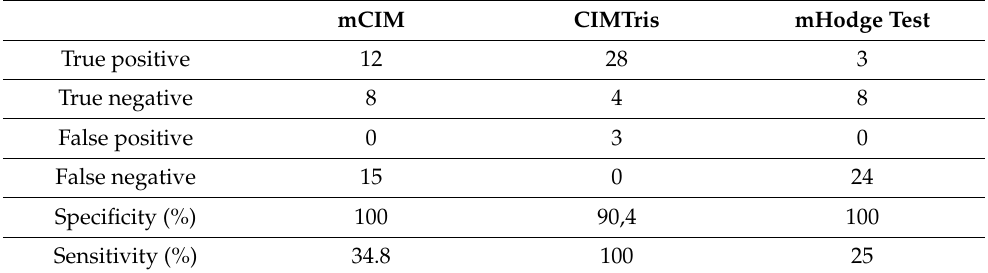
Table 5. Comparison of three phenotypic methods for carbapenemase detection in Pseudomonas aeruginosa strains.